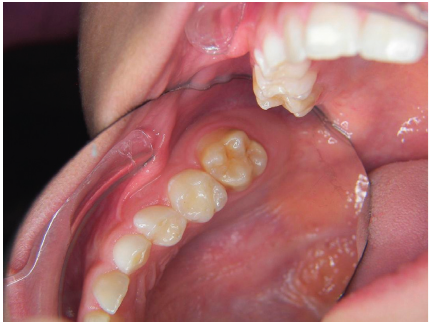
Figure 1: Mild molar hypomineralization.